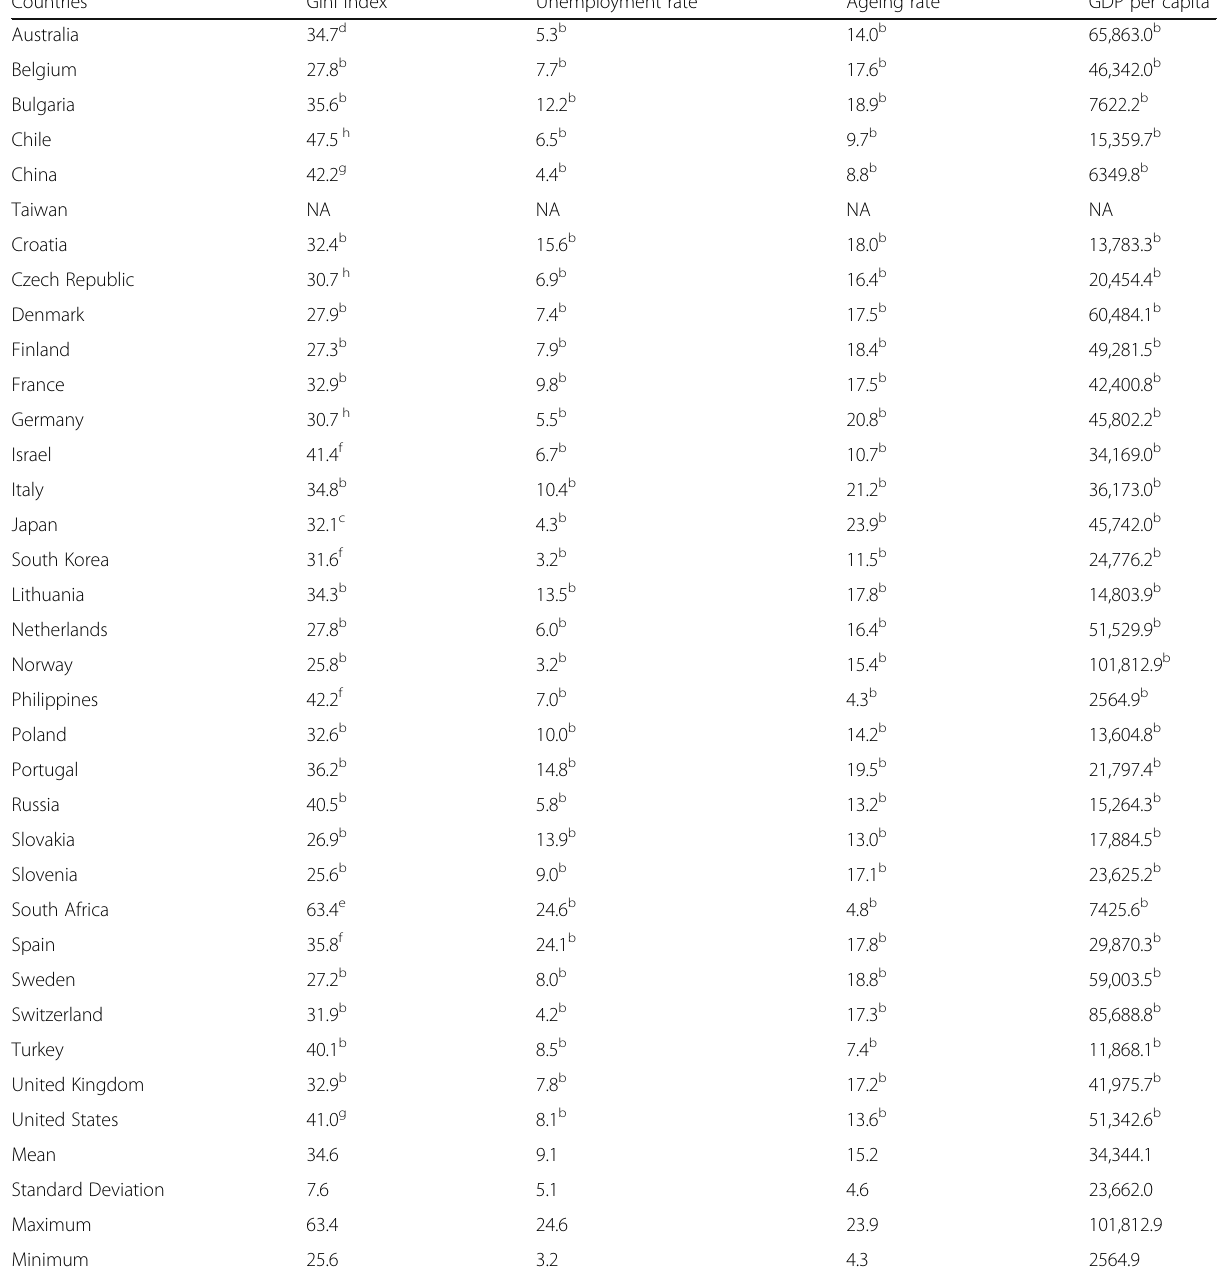
Table 2 Statistics of social structural indicators of the 32 target countries Countries Gini index